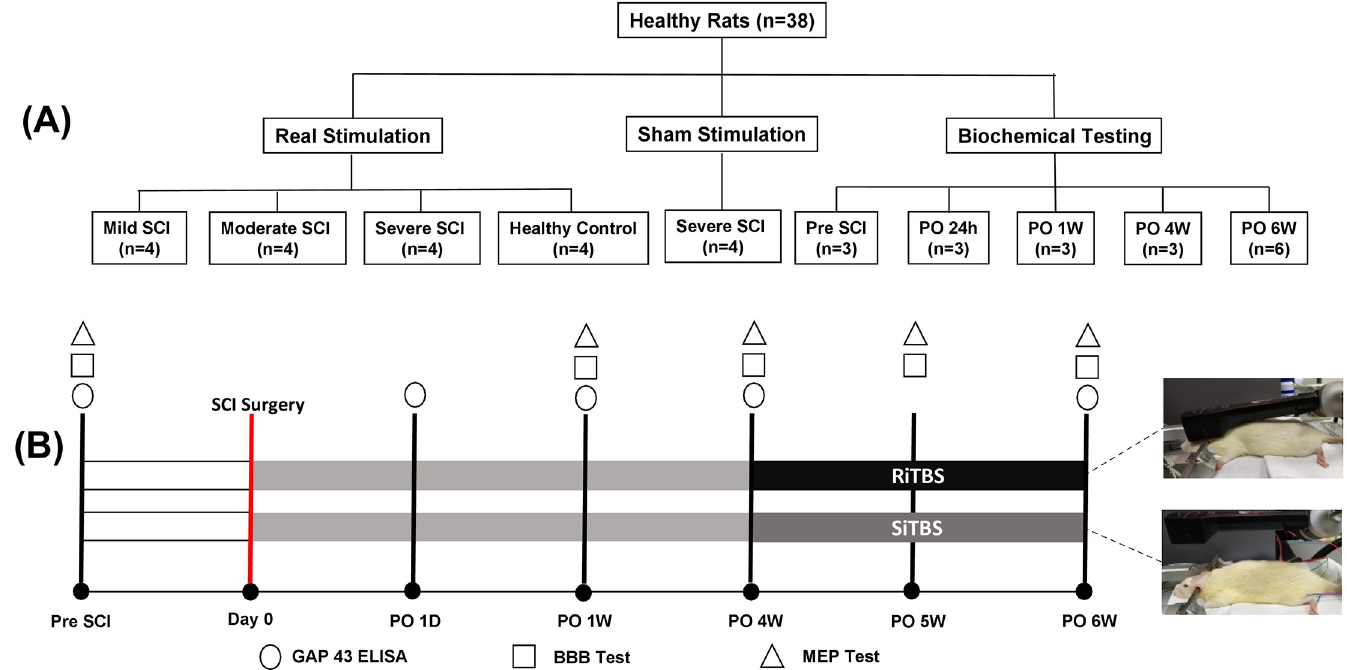
Fig 1. Schematic of the experimental design in this study. (A) Time-course analyses of motor-evoked potentials (MEPs), the Basso Beattie Bresnahan (BBB) scale, and a growth-associated protein (GAP)-43 ELISA were conducted. (B) BBB and MEP testing were performed one time pre-spinal cord injury (SCI) and once each at weeks 1, 4, and 6 following the SCI. A GAP-43 ELISA was performed pre-SCI and post-SCI at 24 h, and at weeks 1, 4, and 6 following a severe SCI and after intermittent theta burst stimulation (iTBS). � PO, postoperative; D, day; W, week; RiTBS, real intermittent theta-burst stimulation; SiTBS, sham intermittent theta-burst stimulation. � PO, postoperative; W, week; RiTBS, real intermittent theta-burst stimulation; SiTBS, sham intermittent theta-burst stimulation.